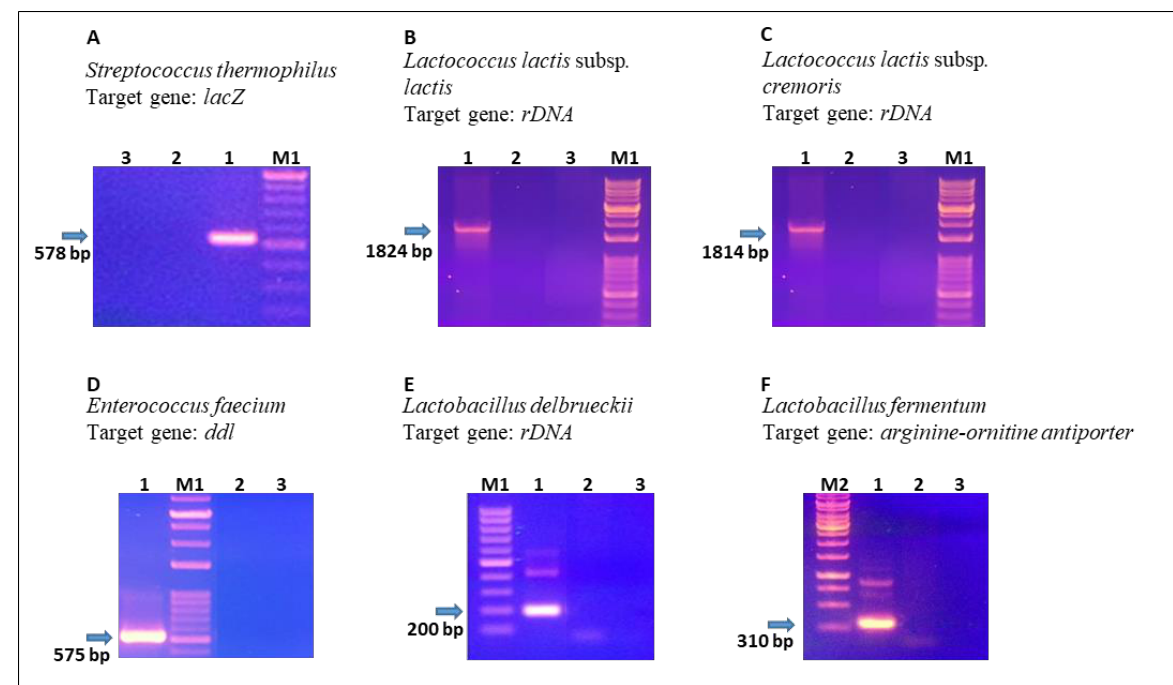
Figure 1. Amplification products obtained from the species/subspecies-specific PCR assay. An example of amplification product for each species isolated from NWSs is reported. In each panel lane 1 is loaded with the amplification product of the specific target gene and lanes 2 and 3 are negative controls. ( Panel A ). Lane 1: PCR product of amplified lac Z gene on S. thermophilus isolates; lanes 2 and 3: PCR on L. lactis DNA or without DNA, respectively. ( Panel B ). Lane 1: PCR product of amplified 16S rDNA (V1) and 16S/23S spacer region on L. lactis subsp. lactis isolates; lanes 2 and 3: PCR on L. lactis subsp. cremoris DNA or without DNA, respectively. ( Panel C ). Lane 1: PCR product of amplified 16S rDNA (V1) & 16S/23S spacer region on L. lactis subsp. cremoris isolates; lanes 2 and 3: PCR on L. lactis subsp. lactis DNA or without DNA, respectively. ( Panel D ). Lane 1: PCR product of amplified ddl gene on E. faecium isolates; lanes 2 and 3: PCR on E. hirae DNA or without DNA, respectively. ( Panel E ). Lane 1: PCR product of amplified 16S-23S rDNA spacer region on L. delbrueckii isolates; lanes 2 and 3: PCR on L. plantarum DNA or without DNA, respectively. ( Panel F ). Lane 1: PCR product of amplified arginine-ornitine antiporter gene on L. fermentum isolates; lanes 2 and 3: PCR on L. plantarum DNA or without DNA, respectively. M1: 1kb Opti-DNA (abm); M2: Hyper ladder 1 kb (Bioline).